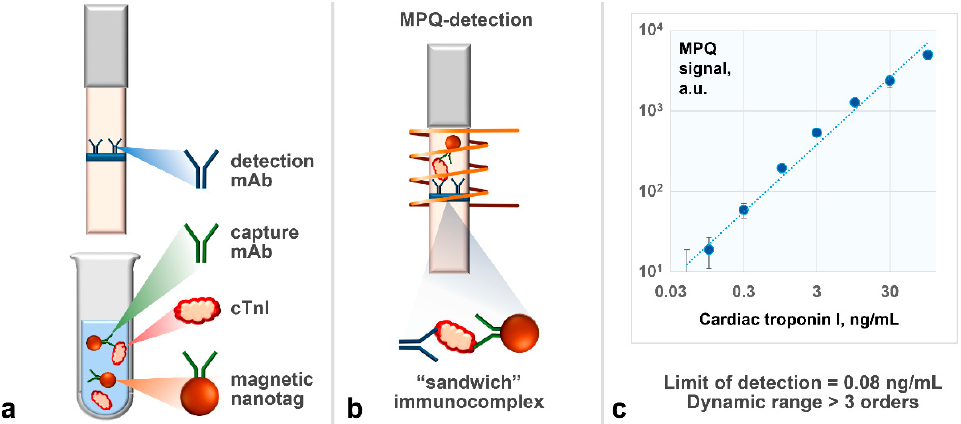
Figure 4. Scheme of the lateral flow sandwich immunoassay based on magnetic nanotags ( a , b ) and calibration plot as a dependence of magnetic signal from the lateral flow test strip upon concentration of cTnI spiked into commercial samples of troponin-free human serum ( c ).